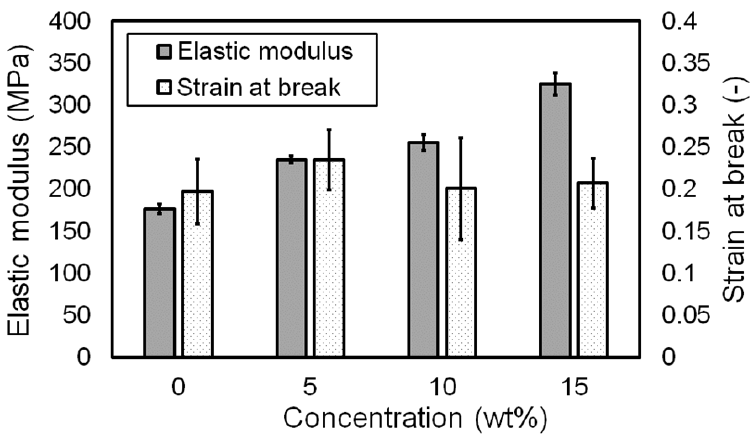
Figure 10. Elastic modulus and strain at break with respect to pigment concentration.